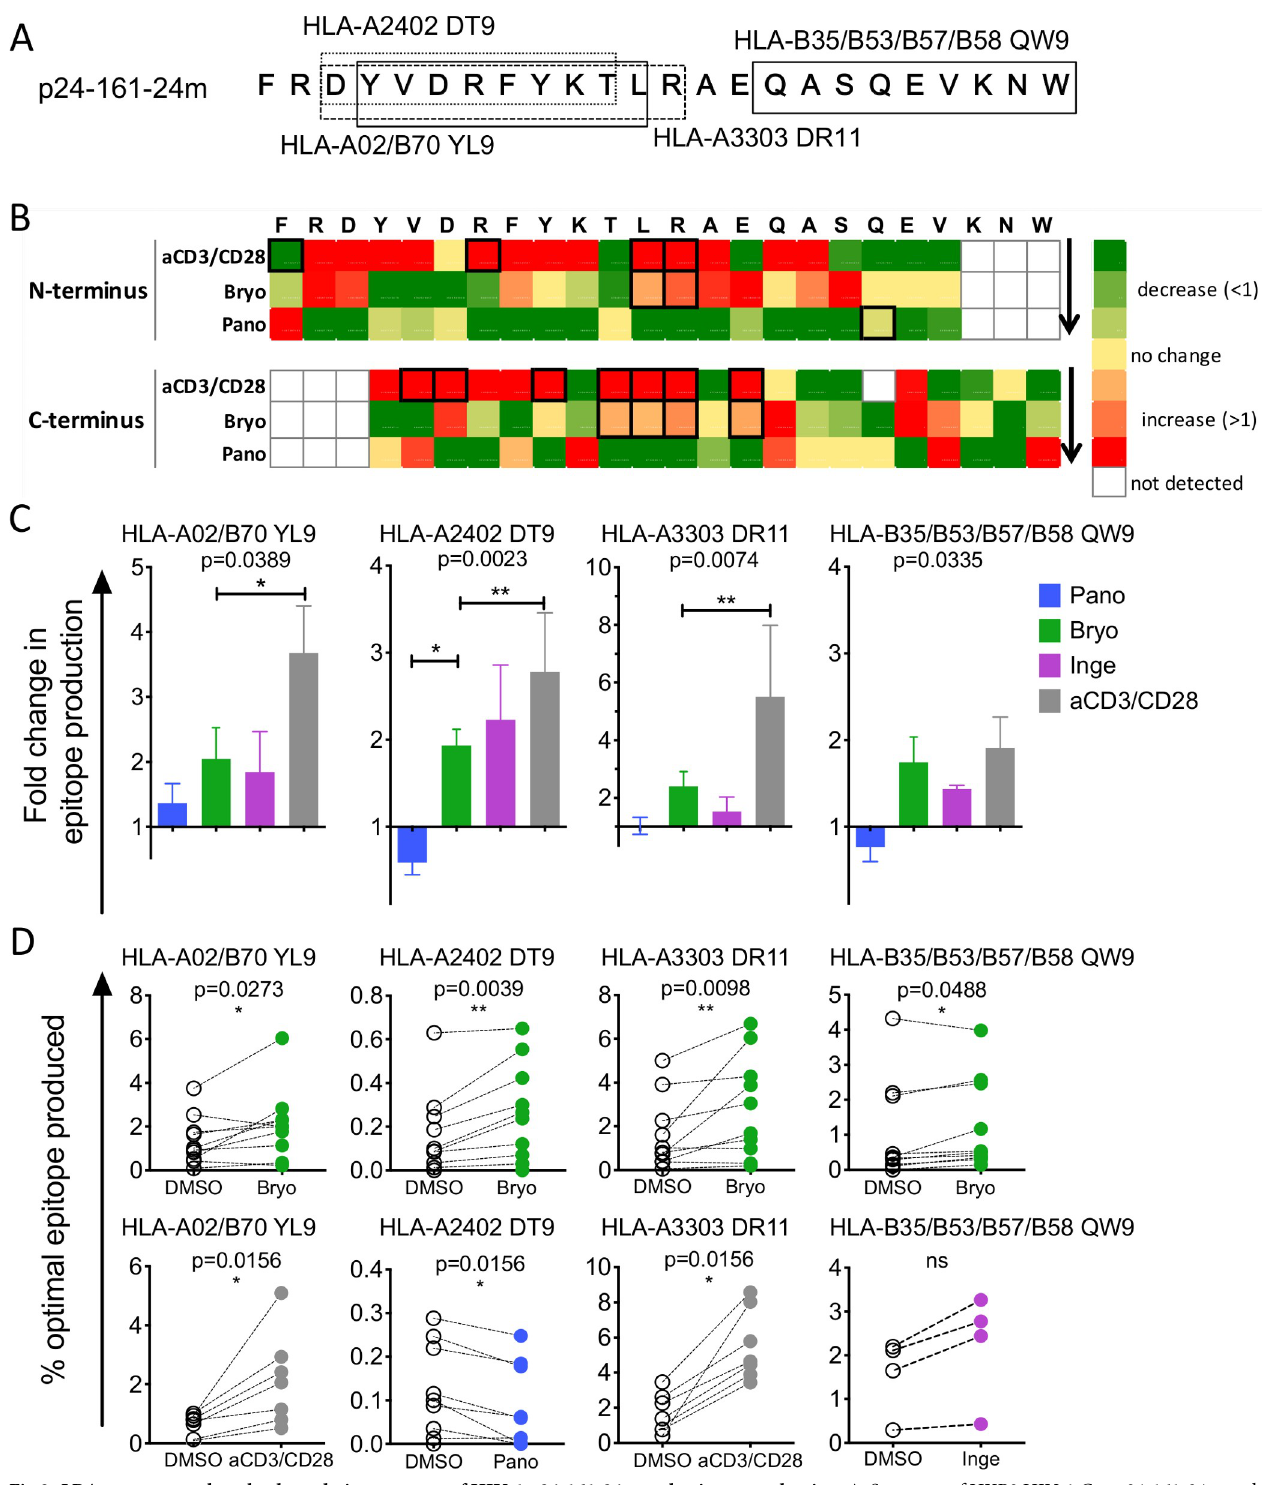
Fig 3. LRA treatments alter the degradation patterns of HIV-1 p24-161-24m and epitope production. A. Sequence of HXB2 HIV-1 Gag p24-161-24m and MHC-I HIV epitopes. B. Reading vertically the heat map shows changes in the amount of degradation fragments starting (N-terminus, top) or ending (C- terminus, bottom) at each position upon LRA treatment over matched DMSO-treated sample in an average of n = 8–11 healthy donors. Wilcoxon matched- pairs signed-rank t tests were performed on matched DMSO- and aCD3/CD28- or LRA-treated primary CD4 T cells extracts. The boxed squares indicate